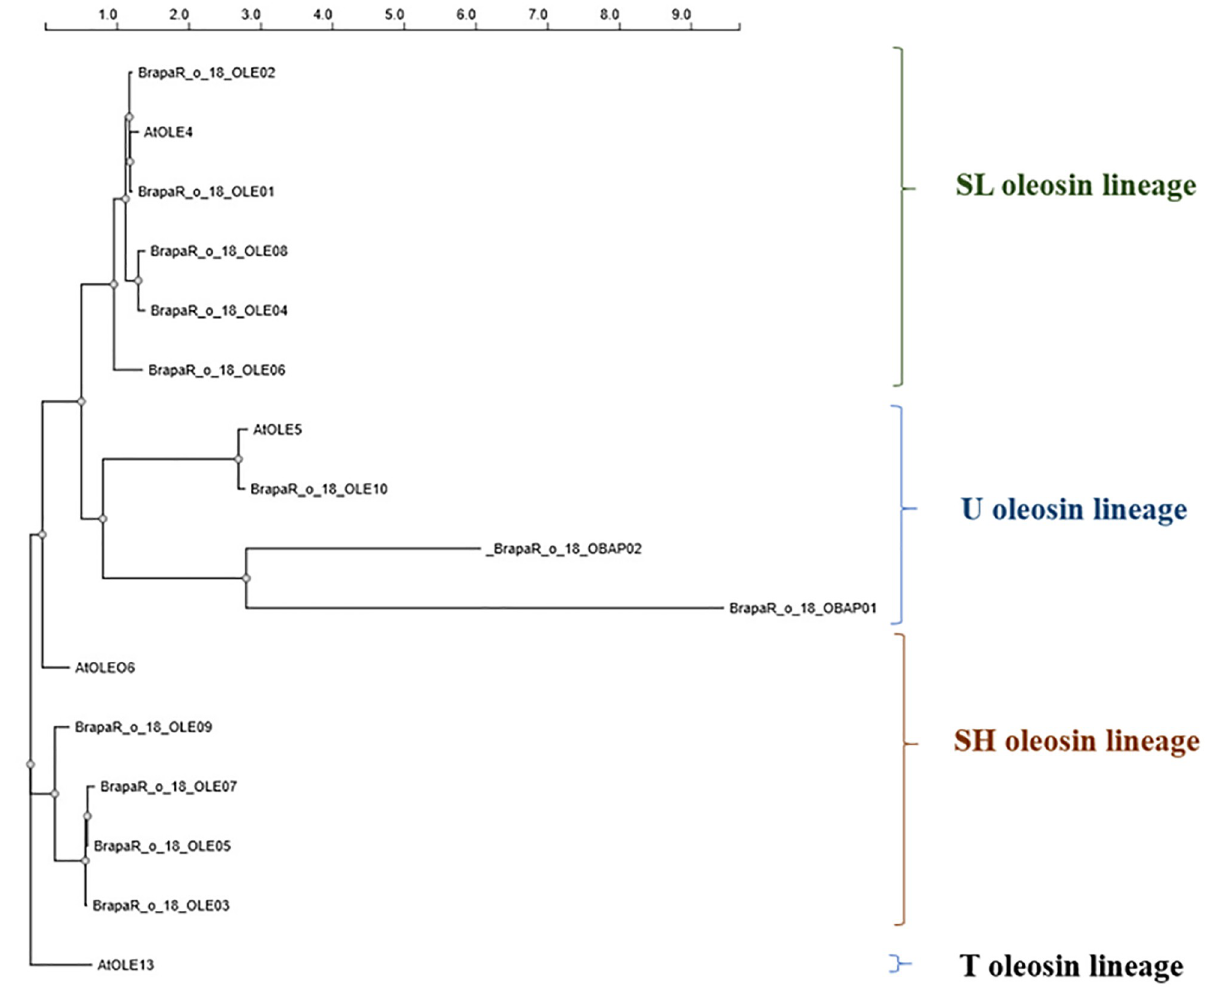
Fig 9. Phylogenetic analysis of identified Brassica rapa oleosin and oil body associated proteins. The linear phylogram was built using PRESTO-Phylogenetic tReE viSualisaTiOn server (https://ngphylogeny.fr/data/displaytree//, 29/09/2020) and shows the relationship to the Arabidopsis oleosin genes (S7 Table in S1 File). The branch length scale at the top of the figure indicates the distance between the sequences based on the sequence similarity of their features. The identified oleosin proteins Bra019493, Bra000167, A0A078GHK4, M4E9X1, A0A397KW15, A0A397ZZI8, M4DBK6, M4EI43, Bra035756, Bra032113 and oil-body associated proteins Bra036039 and Bra036039 are designated as OLE01, OLE02, OLE03, OLE04, OLE05, OLE06, OLE07, OLE08, OLE09, OLE10, OBAP 01 and OBAP 02 respectively.